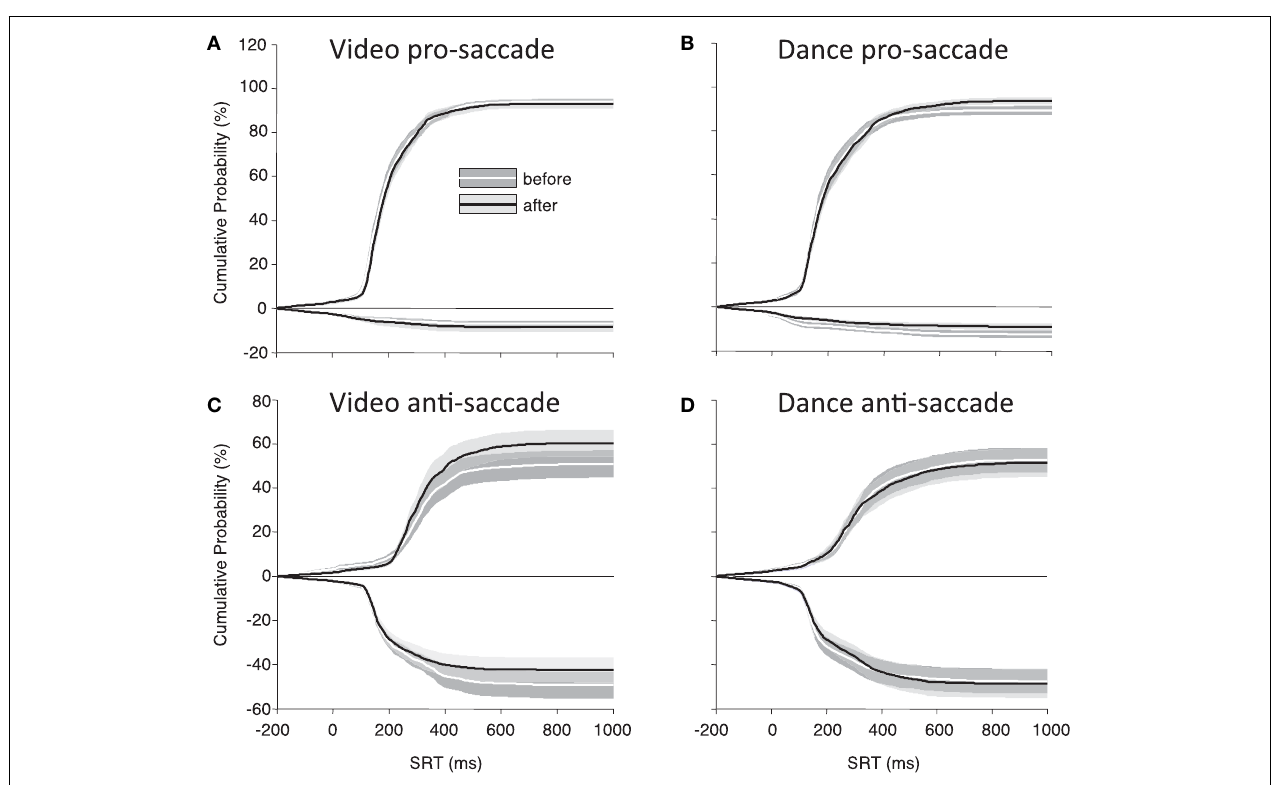
negative Y values indicate direction errors. SRT ( X axis) begins 200ms before target onset to include anticipatory saccades. Shading indicates standard